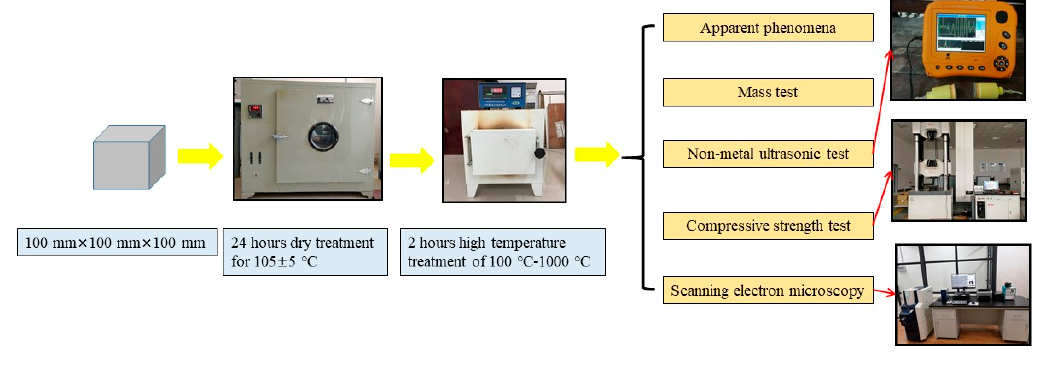
Figure 3. Test procedure.